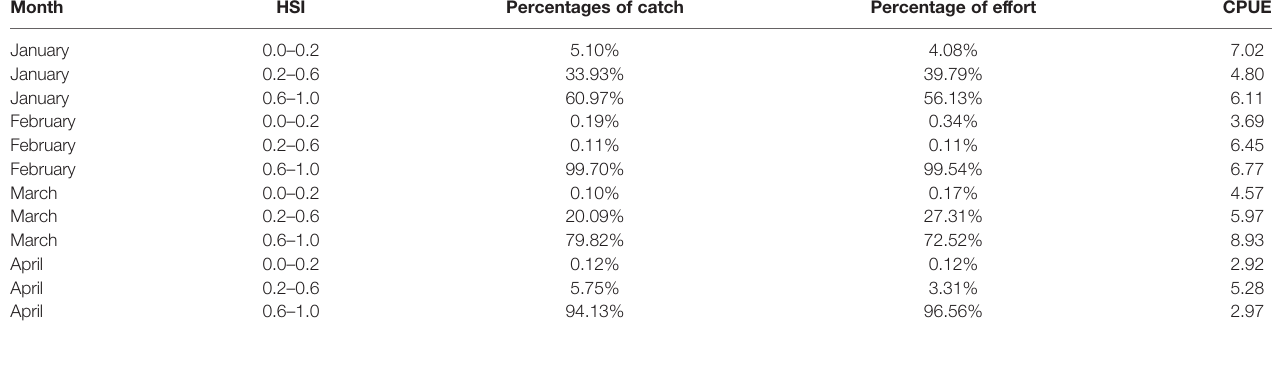
TABLE 5 | Forecast results of comprehensive HSI model in 2017 (the results of validation). Month HSI